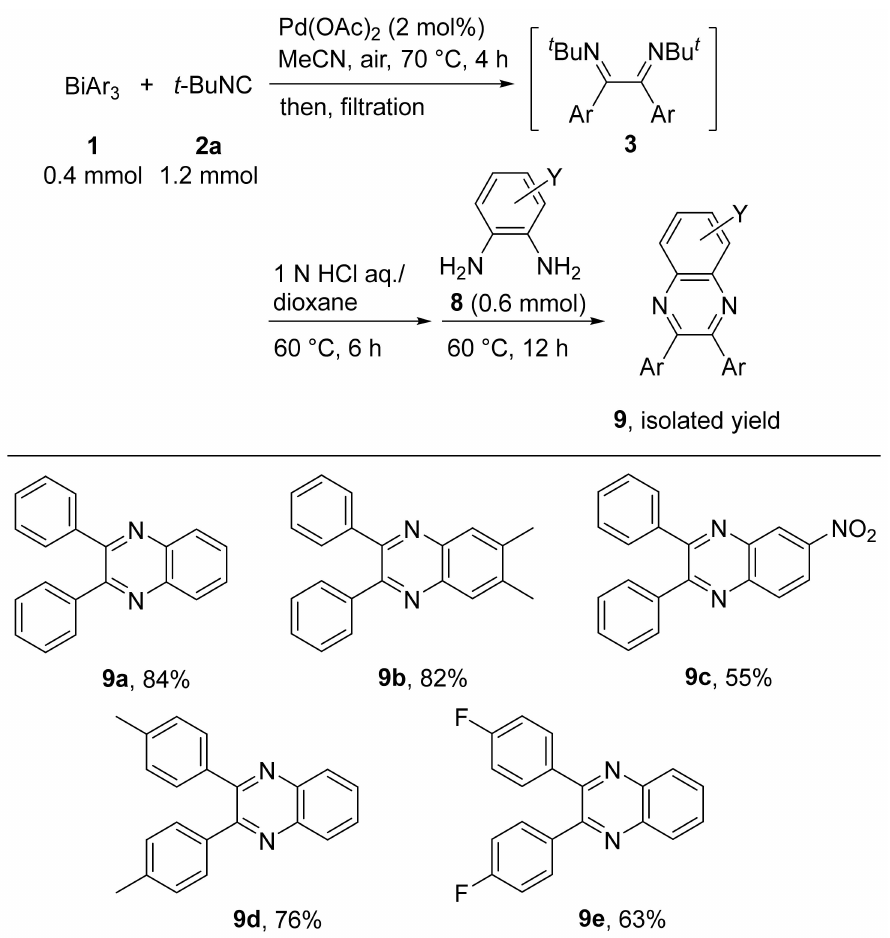
Scheme 6. Application to cascade synthesis of